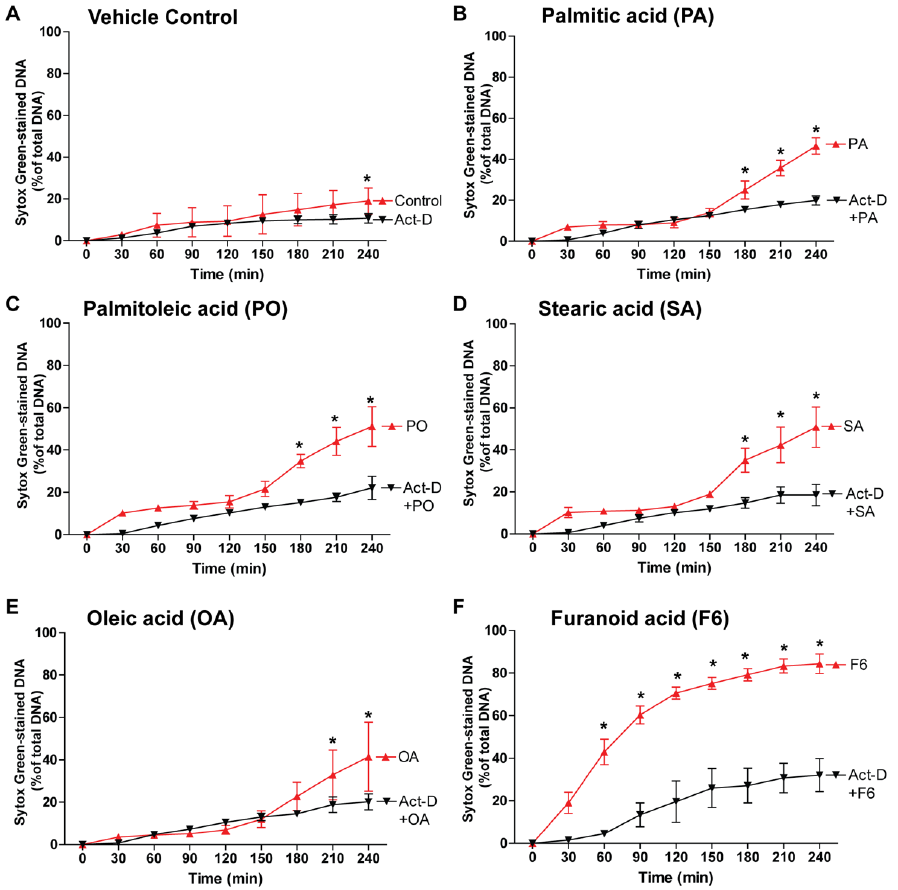
Figure 7. Fatty acid-induced NETosis involves transcriptional firing. ( A – F ) Neutrophils were pre-incubated 1 h either with actinomycin-D followed by incubation with ethanol ( − ve control), PA, PO, SA, OA, or F6. NETosis kinetics data indicate that the transcriptional firing is important for all the tested compounds as actinomycin-D suppresses NETosis released by these fatty acids ( n = 3–4, * p -value < 0.05 comparing between compound with and without inhibitors; two-way ANOVA with Bonferroni’s multiple comparison